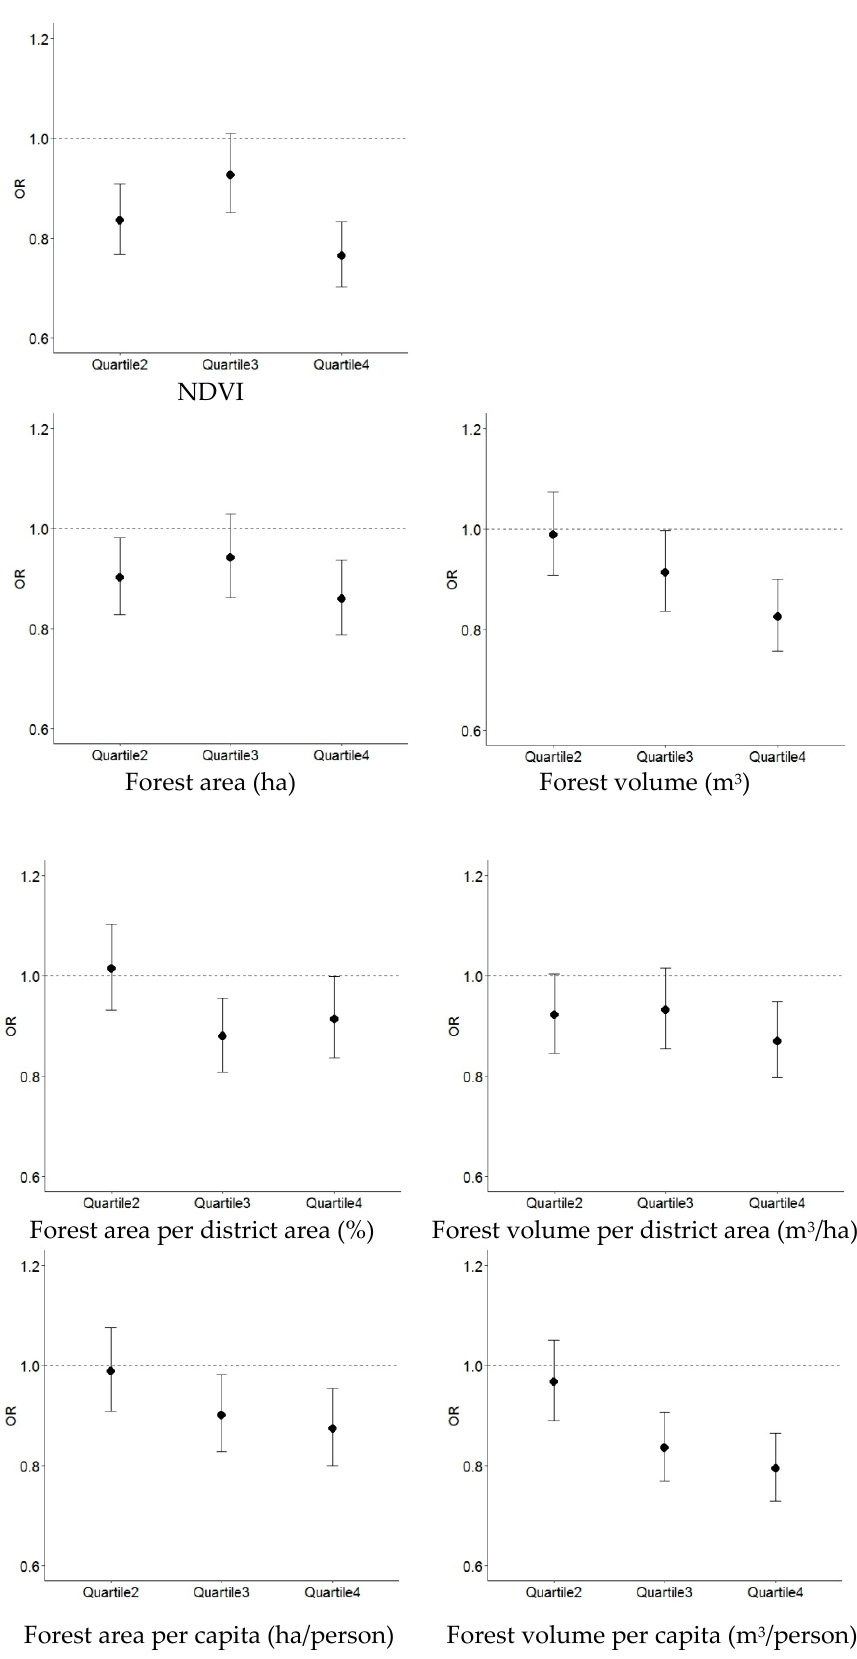
Figure 2. Fully adjusted ORs for reporting depressive symptoms in the quartiles for urban greenness by various greenness indicators. NDVI: Normalized Difference Vegetation Index ．